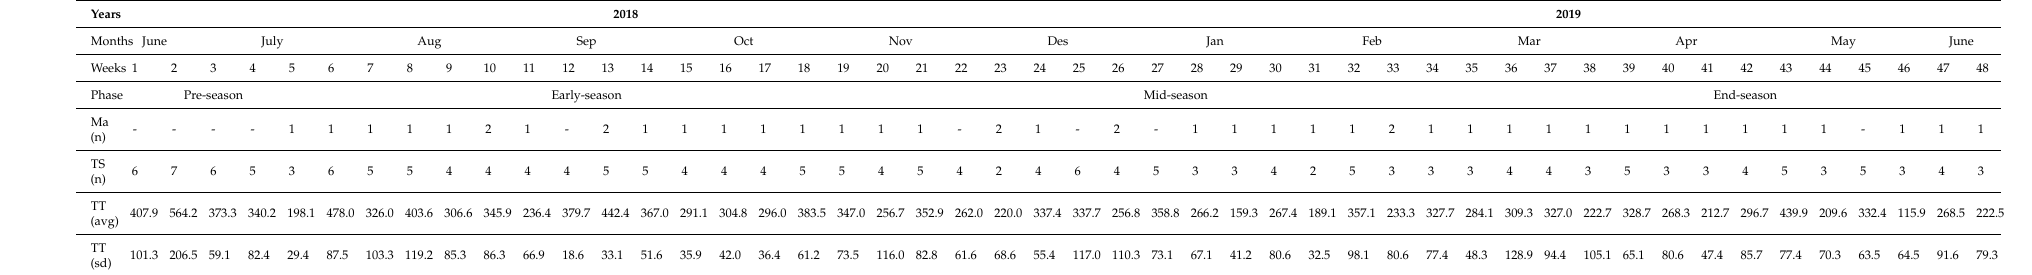
Table 1. Monitoring the periods of the full